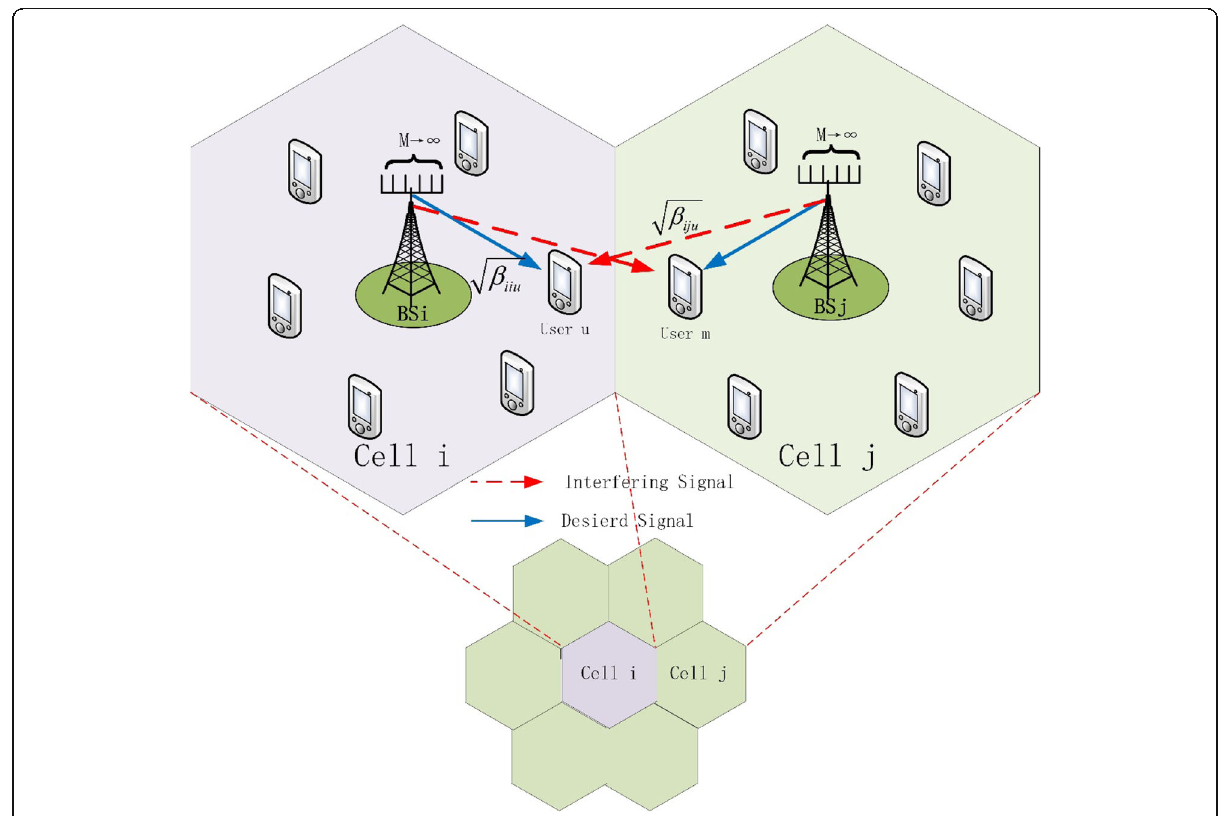
Fig. 1. Illustration of the downlink multi-cell multi-user massive MIMO network transmission